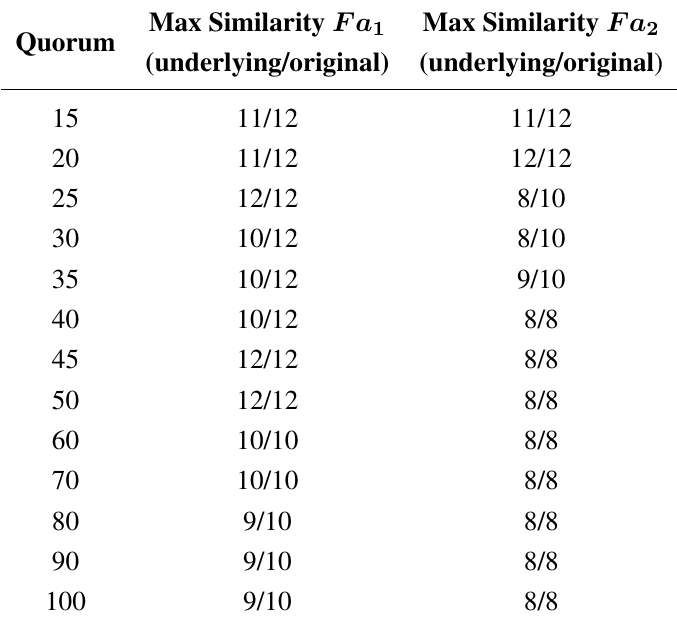
Table 6. Normalized maximum similarity with the reference patterns of the family coagulation factors 5/8 type C domain, for different quorums. Max Similarity F a 1 Max Similarity F a 2 Quorum (underlying/original) (underlying/original ) 15 11/12 11/12 20 11/12 12/12